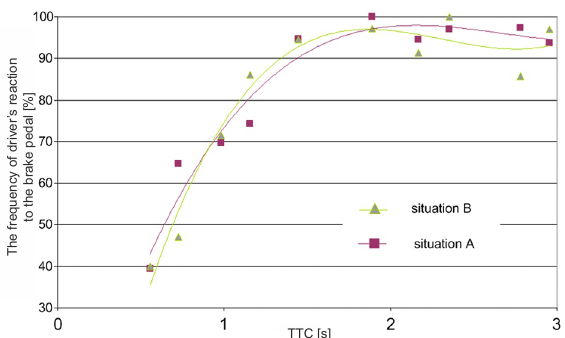
Fig. 17. The values of the frequency of brake pedal reaction